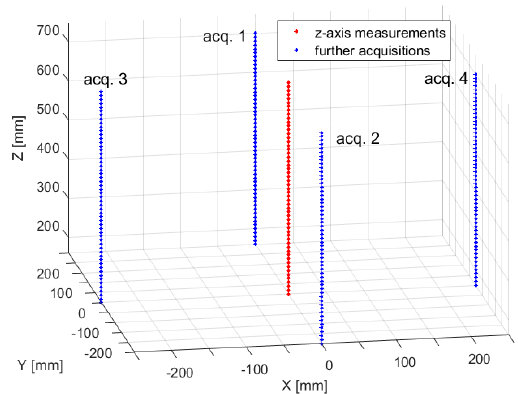
pseudoinverse of the Jacobian matrix